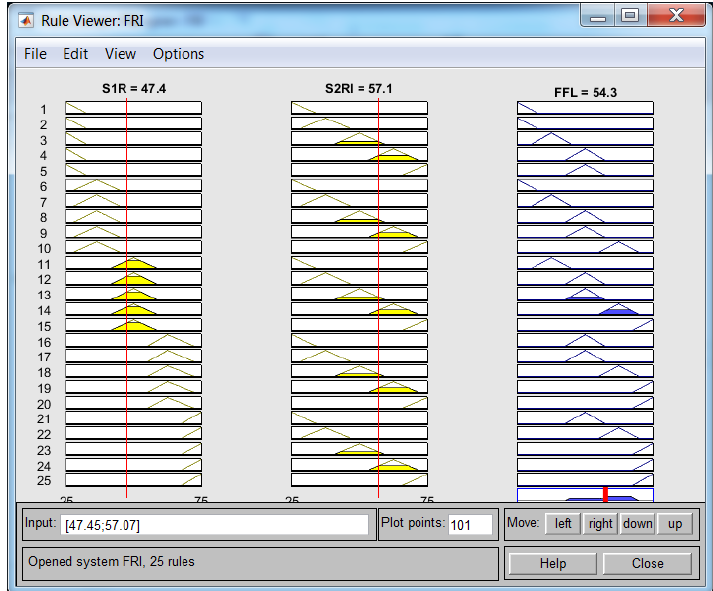
Figure 9. Rule viewer for the output variable of FIS_3.